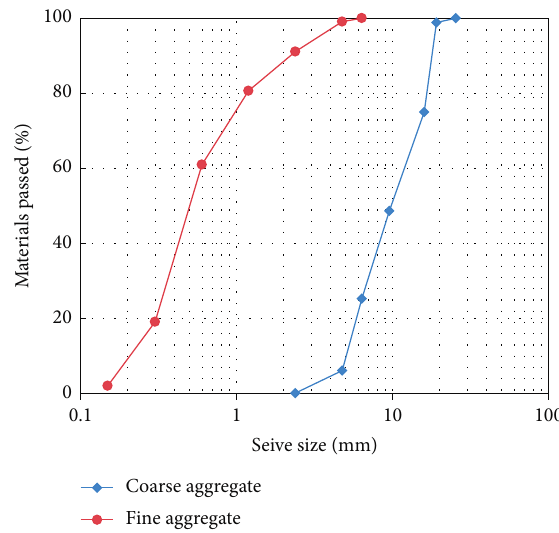
Figure 1: Fine and coarse aggregates size